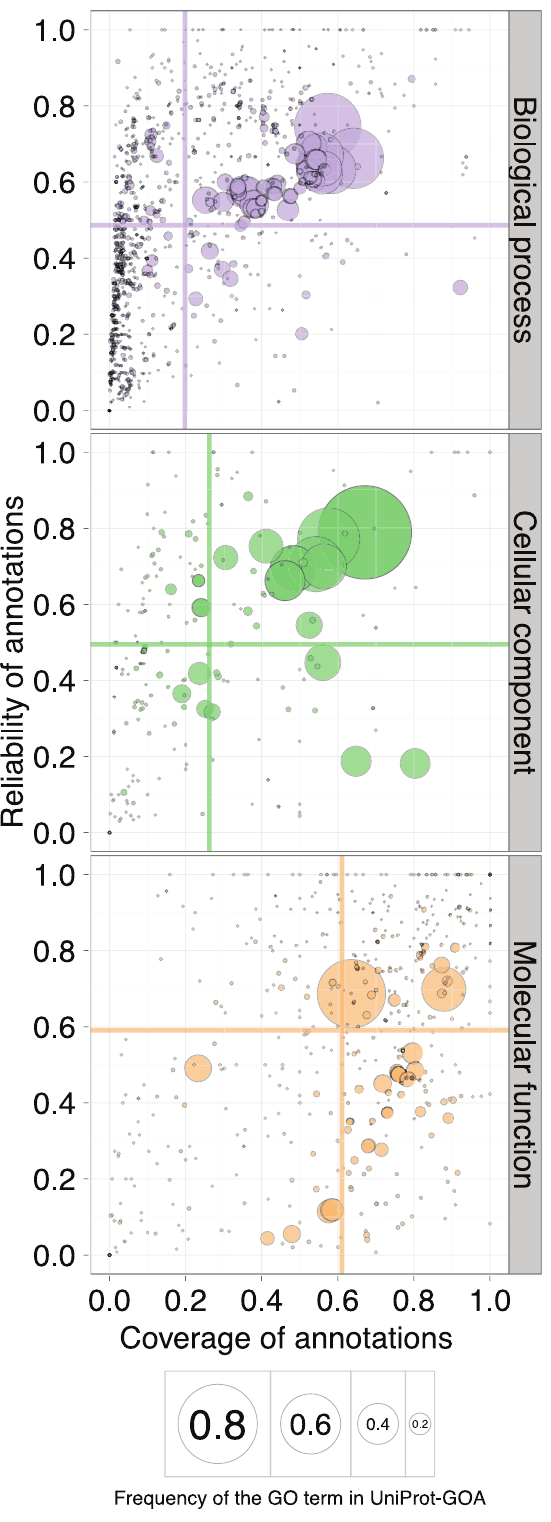
Figure 5. The quality of the 16-01-2008 UniProt-GOA release, evaluated by the 11-01-2011 UniProt-GOA release. A scatterplot of coverage compared to the reliability for the GO terms of the three ontologies: Biological Process, Cellular Component, and Molecular Function. The area of the disc reflects the frequency of the GO term in the 16-01-2008 UniProt-GOA release. The colored lines correspond